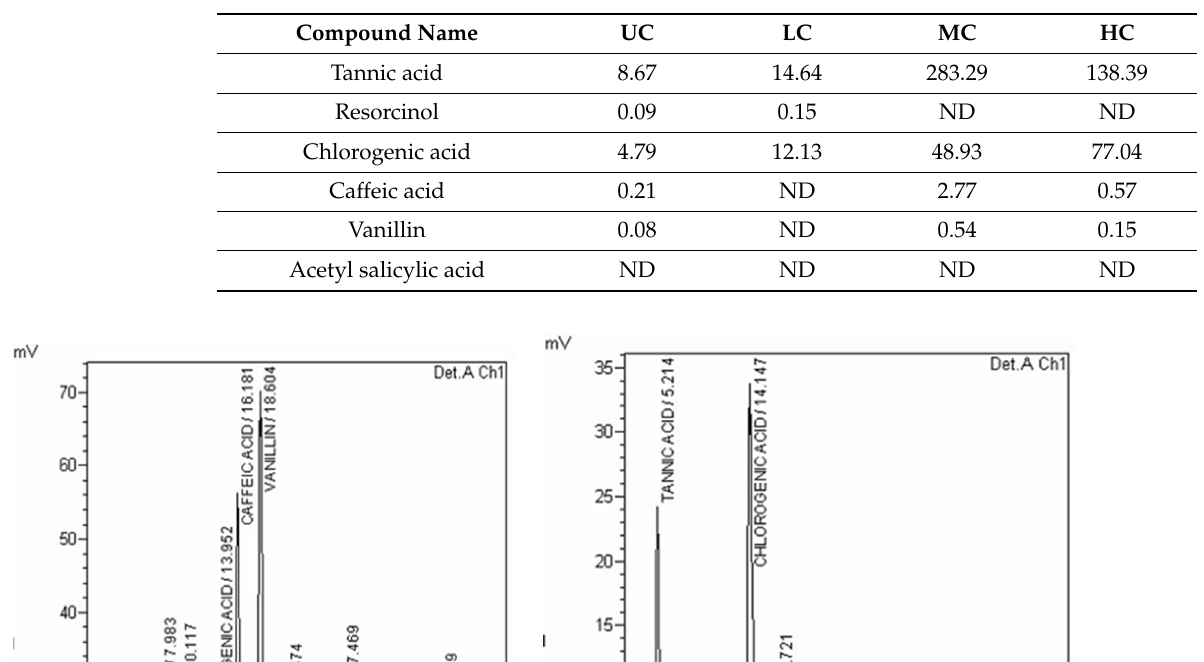
Figure 6. HPLC chromatograms: ( a ) standard compounds; ( b ) high-cooked eggplant extracted with 100% ethanol.